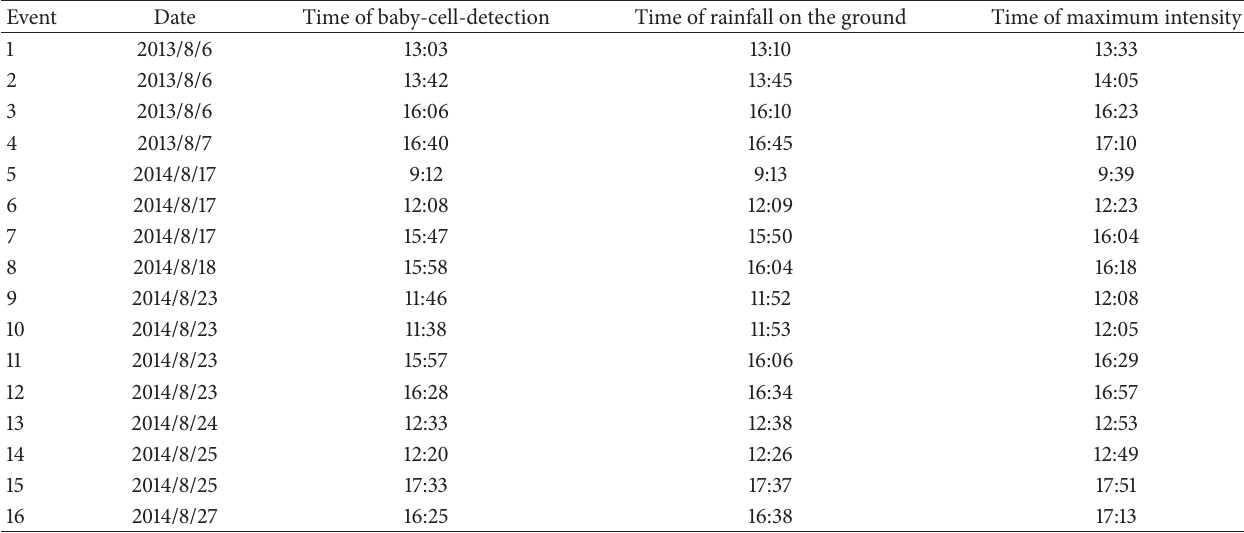
Table 3: List of the Guerrilla-heavy rainfall events used for analysis of vorticity and vortex tubes. This includes occurrence date, time of first echo detection, first time of rainfall recorded on the ground, and time of maximum rainfall intensity.